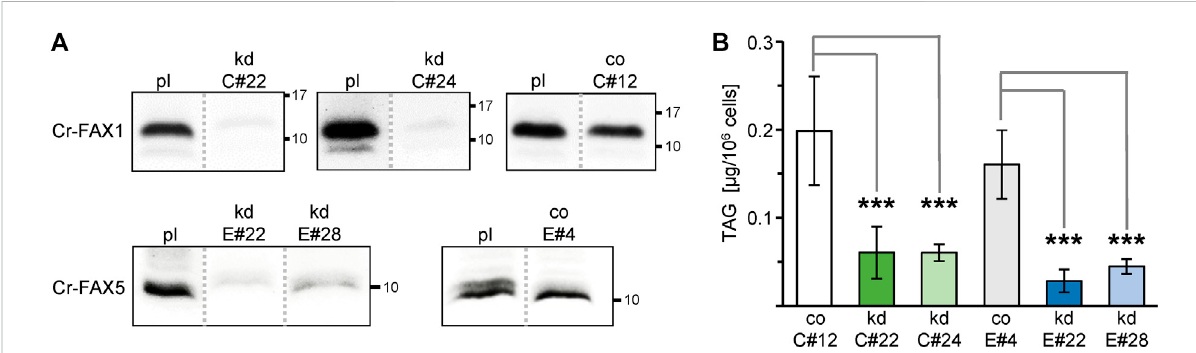
FIGURE 5 Knockdown of Cr-FAX1 and Cr-FAX5 affects oil content in Chlamydomonas. (A) Knockdown of Cr-FAX1 and Cr-FAX5 in cw15-325 Chlamydomonas cells. Immunoblot analysis of Cr-FAX1 and Cr-FAX5 in protein extracts from Chlamydomonas cells that were transformed with amiRNA knockdown constructsfor Cr-FAX1(kd-C,upperpanels) andfor Cr-FAX5 (kd-E, lowerpanels)undercontrolof theinducible NIT1 promoter (see Figure 1A). Proteins were extracted from cells of the independently derived Cr-FAX1 strains kd-C#22, kd-C#24, co-C#12 and Cr-FAX5 strains kd-E#28, kd-E#22, co-E#4 as well as the respective untransformed parental strain cw15-325 (pl). Equal amounts of proteins (isolated from the same quantity of cells corresponding to 2 μ g chlorophyll) were separated by SDS-PAGE and subjected to immunoblot analysis using antisera directed against Cr-FAX1 (upper panels) and Cr-FAX5 (lower panels). Numbers indicate molecular mass of proteins in kDa. Note that all protein samples wereextracted fromnon-inducedChlamydomonas cells, i.e., knockdownsresult fromleakyexpression ofthe NIT1 promoter.Whilefor the strains kd-C#22, kd-C#24, and kd-E#22, kd-E#28, we observed a strong reduction of Cr-FAX1 and Cr-FAX5 proteins, respectively, the strains co- C#12, co-E#4 showed no knockdown effect under these conditions and thus were used as control (co) lines. All boxed immunoblot signals